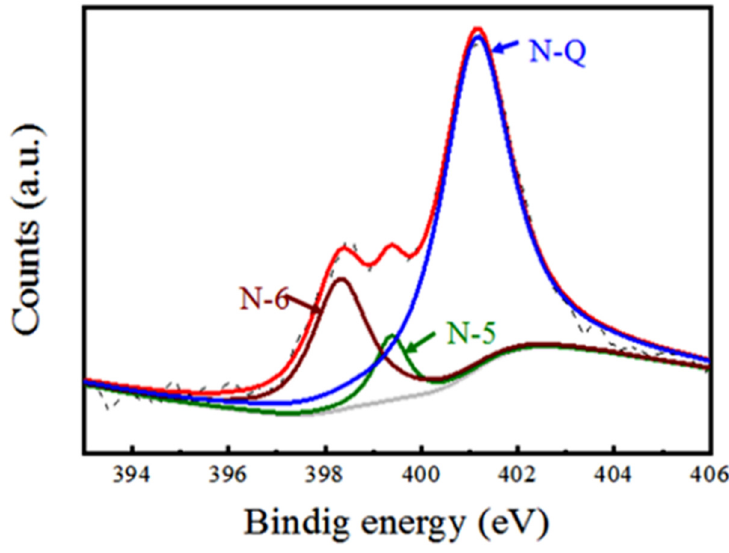
Figure 4. XPS spectra for N1s of NSG@GF.